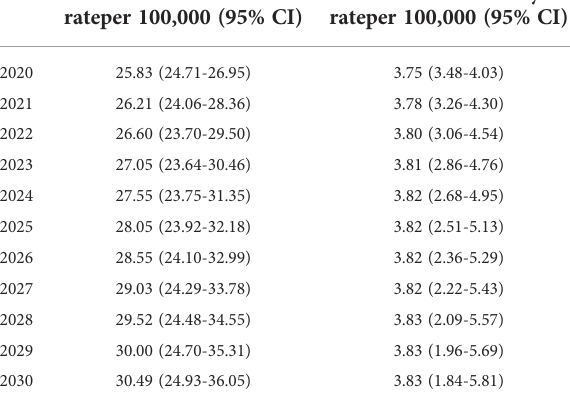
TABLE 2 Prediction of incidence and mortality of FeBGCs among AYAs in China in 2020 –